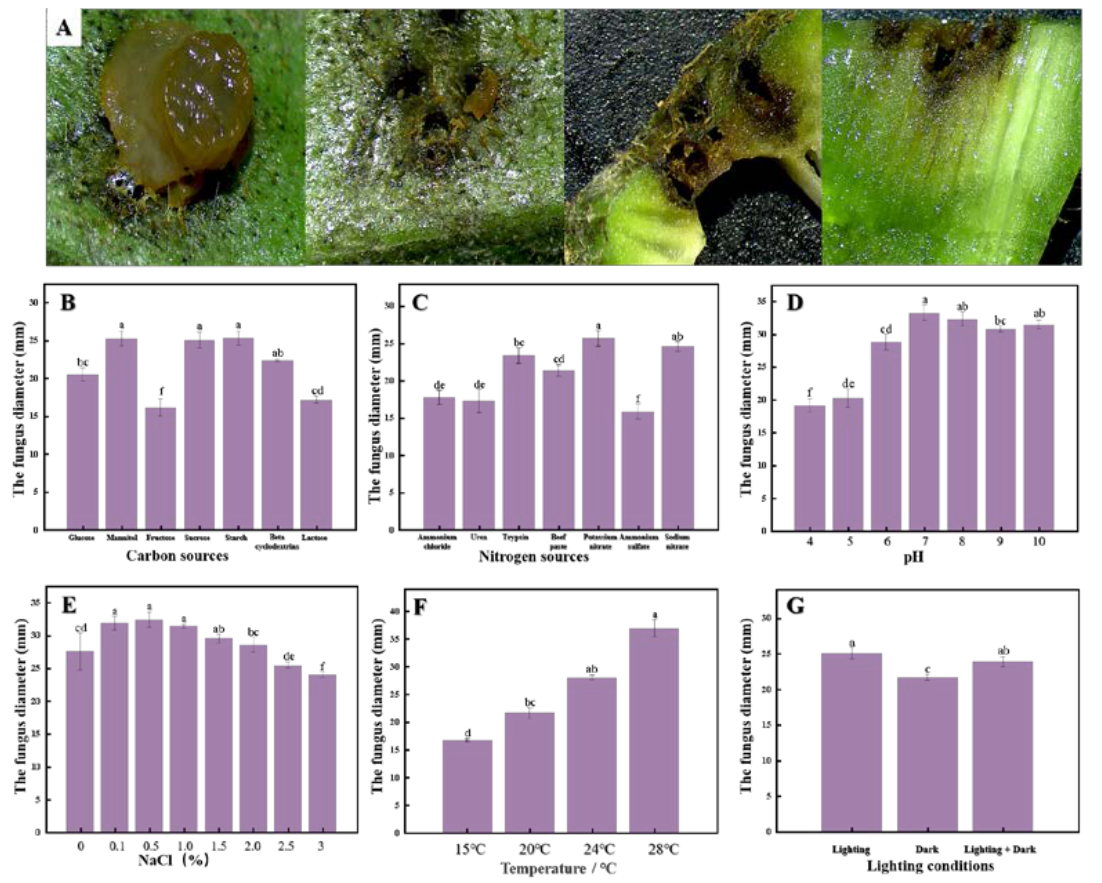
Figure 3. Okra disease under the microscope after being placed at 28 °C for 3 days ( A ), colony diameter under 7 carbon sources ( B ), colony diameter under 7 nitrogen sources ( C ), colony diameter under different pH conditions ( D ), colony diameter under different NaCl concentrations ( E ), colony diameter at different temperatures ( F ), and colony diameter under different light conditions ( G ). SPSS was used for significance analysis and letter marking of significant difference was used. Table 1. Inhibitory effect of TKL at different thymol concentrations on C. fioriniae . Bacteriostatic Agent Thymol Concentration the Fungus